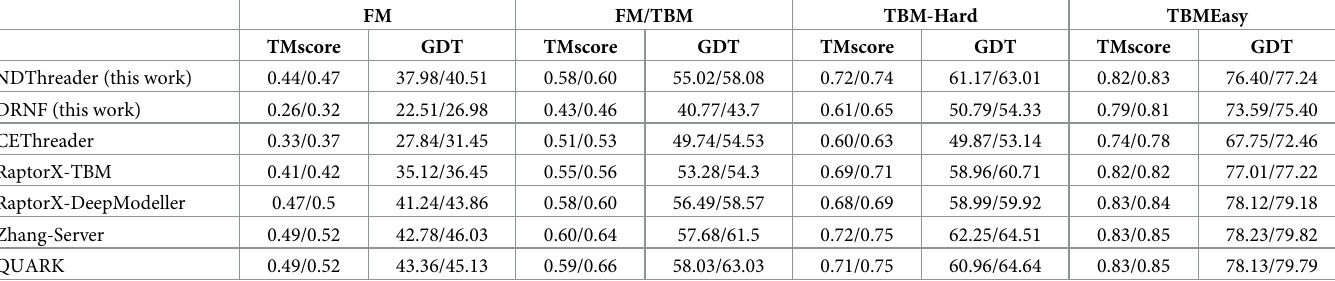
Table 4. Threading performance on 32 CASP13 FM, 13 FM/TBM, 22 TBM-Hard and 45 TBM-Easy domains.